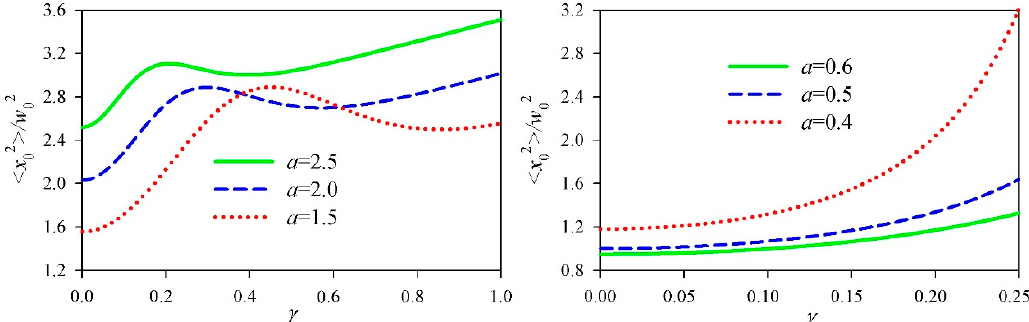
Figure 4. By giving the decay factor a , the square of the beam waist in the x -direction of the cosh-Airy beam as a function of the cosh parameter γ is shown.